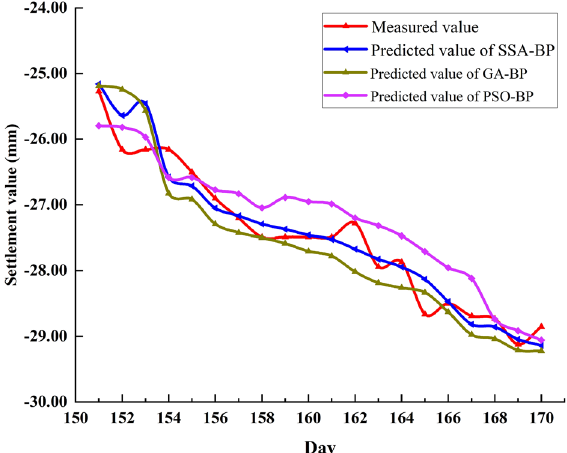
Figure 12. Comparison of predicted values of SSA-BP, GA-BP and PSO-BP at P1.